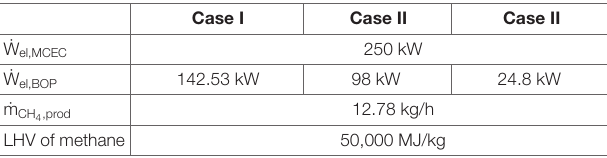
TABLE 2 | The power consumption values of the system for the three